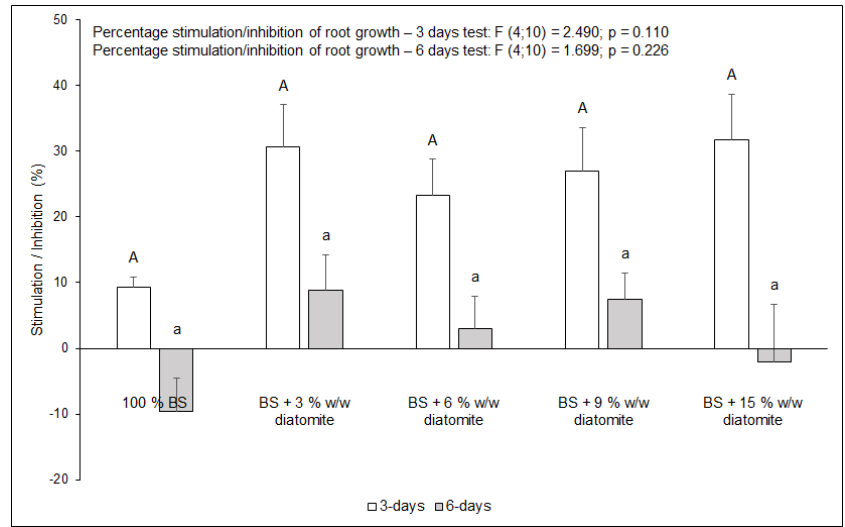
Figure 3. Comparison of inhibition/stimulation of root growth of Sinapis Alba L. after 3 and 6 days of exposure to burnt soil supplemented with diatomite in increasing proportions (applied to OECD soil). Average values (n = 3) + SE are presented, different uppercase letters indicate significant differences between individual variants after 3 days of testing and small letters after 6 days (one-way ANOVA with post hoc Tukey’s HSD test). The results of the F test are shown at the top of the graph. Above mentioned differences in phytotoxicity have not been statistically significant.